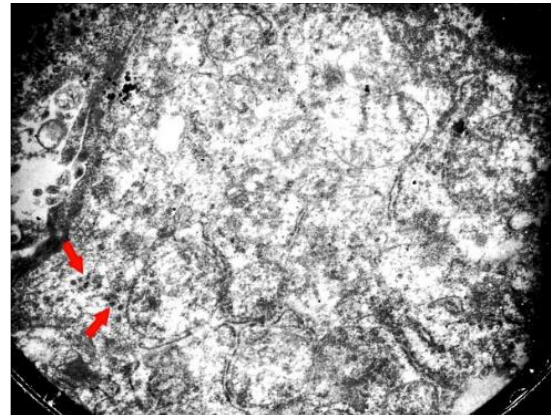
Fig. 3. Electron microscopy showed the presence of virus particles in the cytoplasm and swollen mitochondria about 60 to 150 nm; (Original magnification ×15,000) (Courtesy of Dr.